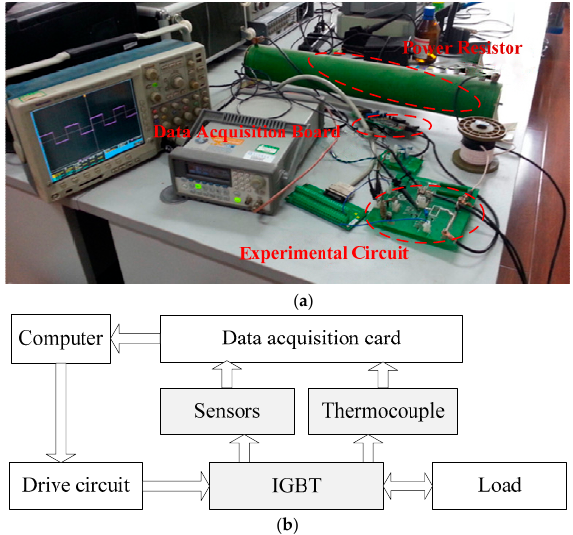
Figure 2. Accelerated life test system: ( a ) Picture of the test system; ( b ) Block diagram of the test system.